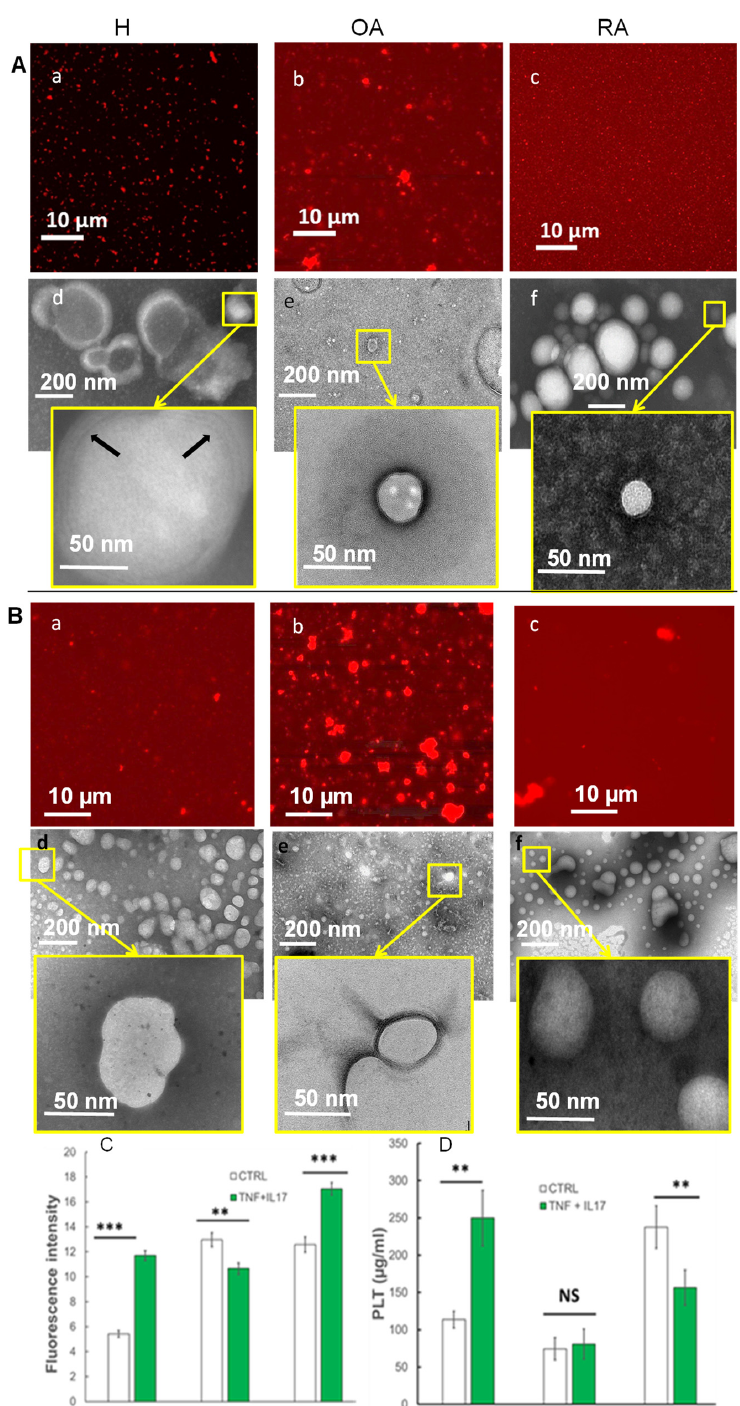
Figure 3. Structural characterization and comparison of supernatants between healthy (H) and pathological (OA and RA) in the absence ( A ) or presence ( B ) of inflammatory environment (IL-17: 50 ng/mL, TNF- α : 1 ng/mL). Differences in vesicular structures were observed by confocal microscopy ( a – c ) and transmission electron microscopy (TEM) ( d – f ) (20 days of cell culture after cell passage 7). Arrows: Phospholipid multilayers. ( C ) Fluorescence intensity of the image. ( D ) PLT concentration ( µ g/mL) in the supernatant. Bars represent mean ± SEM; *** p < 0.0001, ** p < 0.001 and NS